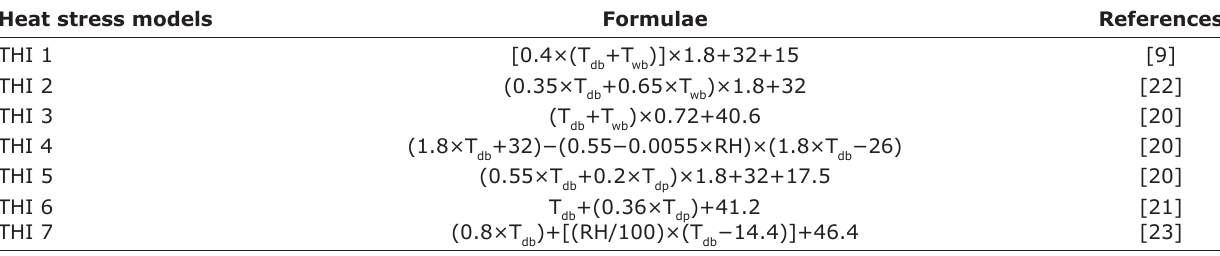
Table-1: Different heat stress models for formulating temperature humidity indices. Heat stress models